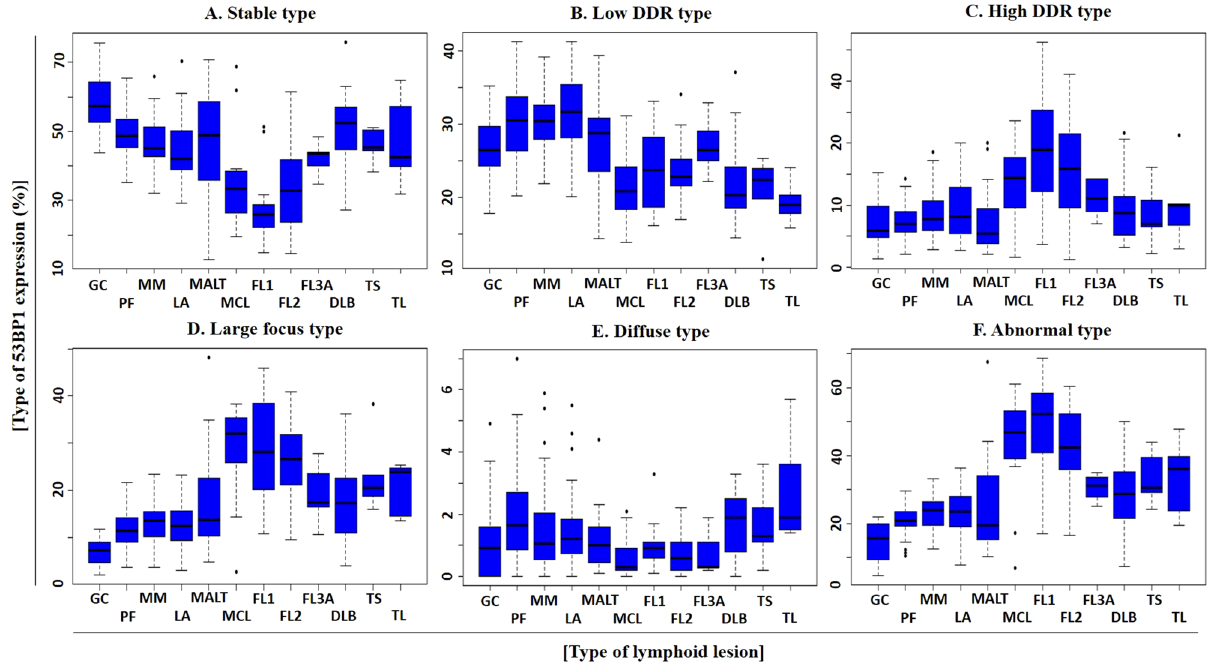
Figure 3. Schematic presentation of results for quantitative analysis of 53BP1 expression in various lymphoid proliferative lesions based on type of 53BP1 expression. Box plots showing frequencies (%) of (A) stable, (B) low DNA damage response (DDR), (C) high DDR, (D) large focus, (E) diffuse, and (F) abnormal types. GC germinal center, PF primary follicle, MM mantle-marginal zone, LA simple lymphoid accumulation, MALT mucosa associated lymphoid tissue lymphoma, MCL mantle cell lymphoma, classical type, FL1, 2, 3A follicular lymphoma grade 1, 2, 3A, DLBCL diffuse large B-cell lymphoma, TS T-cell lymphoma, small cell size, TL T-cell lymphoma, large cell size.